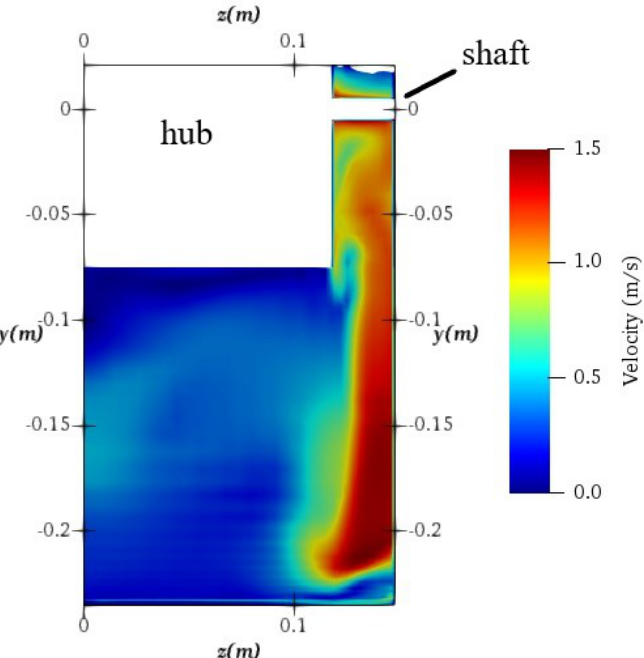
Figure 13. Magnitude of the velocity at the section of the rotation axis ( x = 0.0 m), at time t = 4.0